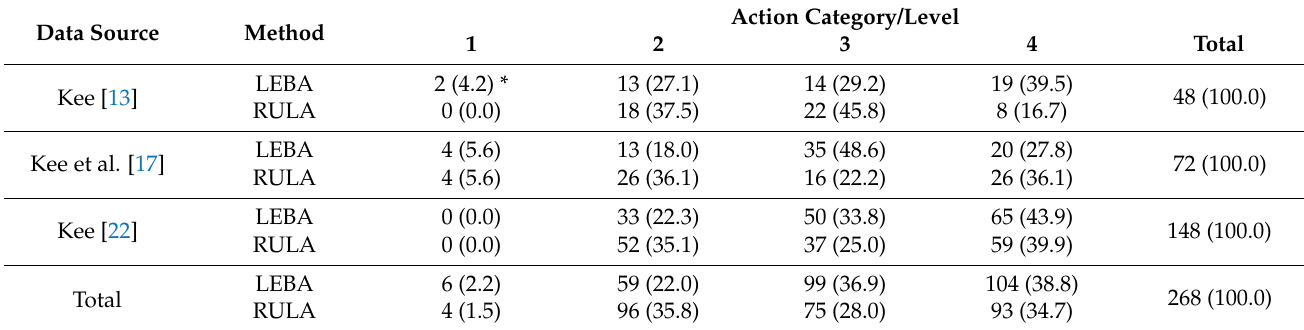
Table 2. Risk levels of the LEBA and RULA in each study.